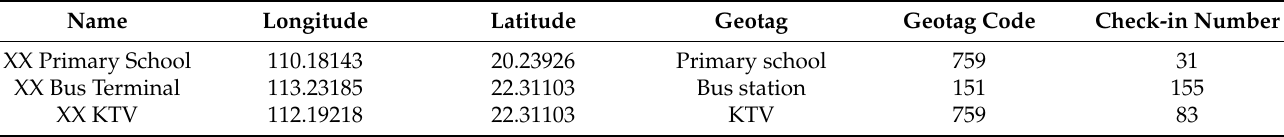
Table A2. The example of check-in data from Sina